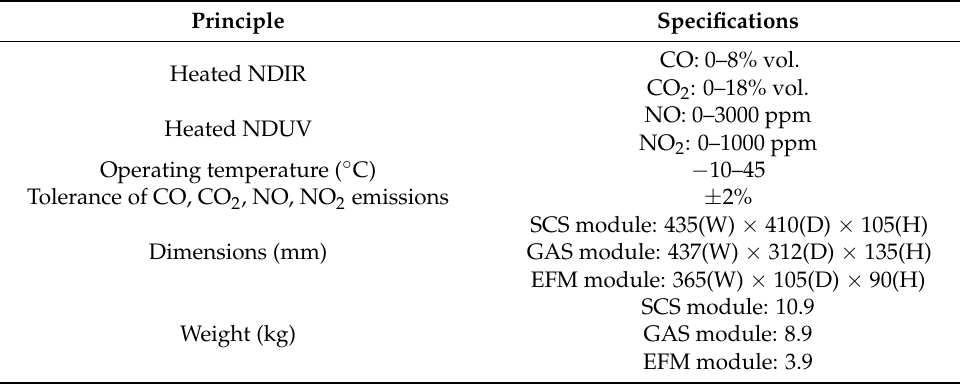
Table 6. Specifications of PEMS equipment